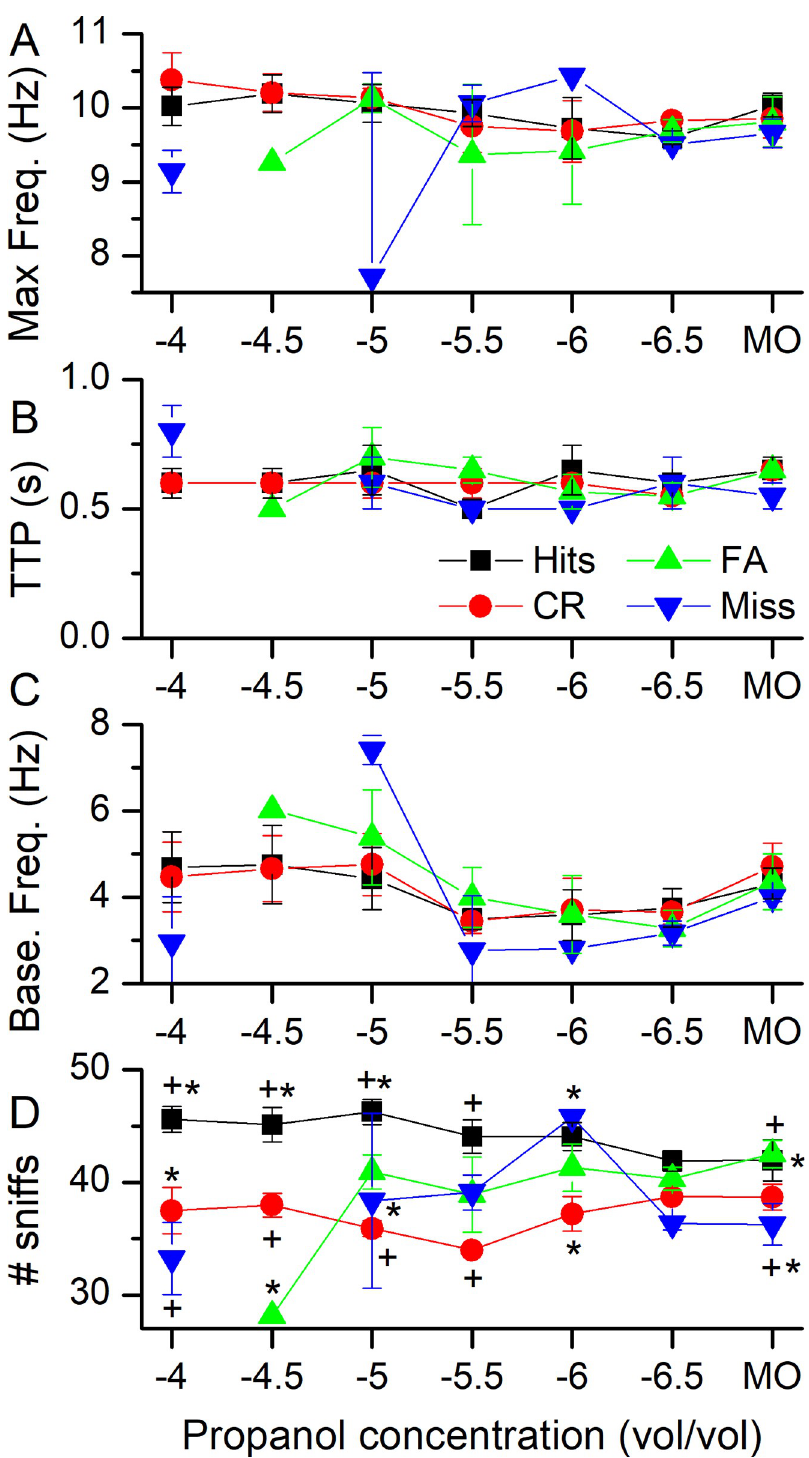
Fig 4. Analysis of multiple parameters of sniffing behavior during the four types of responses to odorant sampling. A The maximal sniff frequency during odorant sampling. B The time to reach maximal sniff frequency calculated from the odorant onset. TTP = time to peak. C Baseline sniff frequency averaged across the sniffing event from -1 to 0 s. D The total number of sniffs taken during the five 200 ms bins centered on 0.5 to 1.3 s. Mixed model ANOVA with interaction term shows mouse behavior and concentration being significant (F = 2.4, p = 0.008),